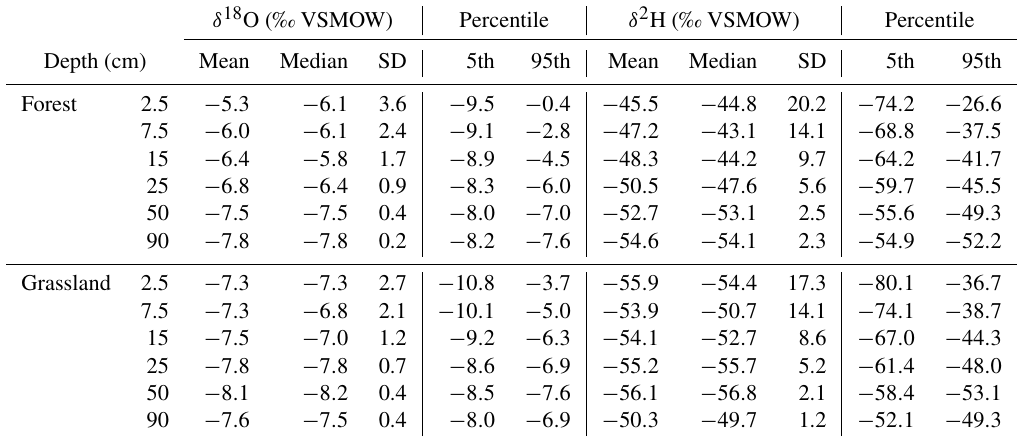
Table 5. Descriptive statistics (mean, median, standard deviation (SD) and percentiles: 5th, 95th) for the geometric mean ( n = 3) of the bulk soil water isotope samples δ 18 O and δ 2 H (‰ VSMOW) values per sites and depths for all sampling dates ( n =